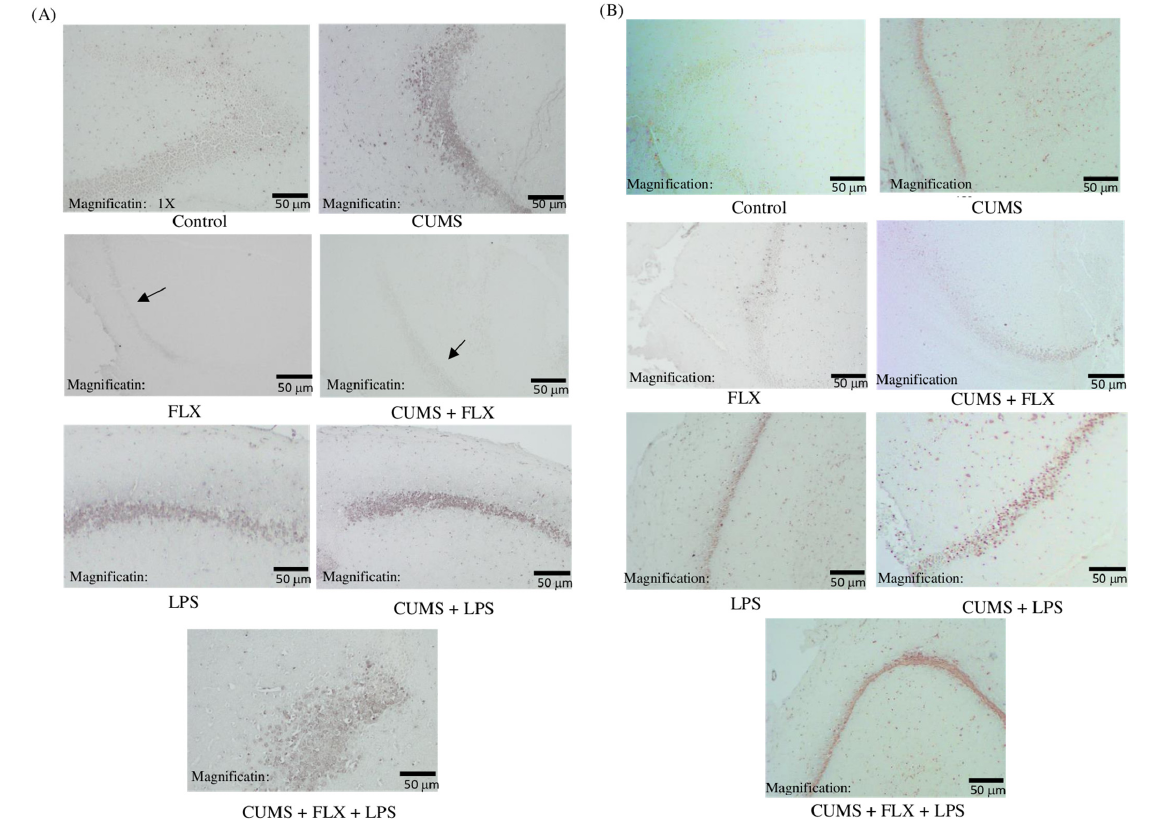
Figure 10. ( A , B ) Effects of Lipopolysaccharide on P-JAK2 and P-STAT3 Pathway in Fluoxetine- Resistant Depression Rats; CUMS: chronic unpredictable mild stress: FLX, fluoxetine; LPS: lipopolysaccharide. Each image is a representative image of the brains of five rats per